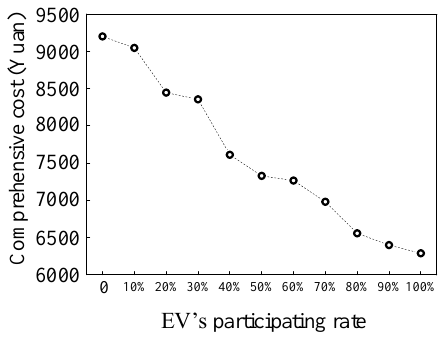
Figure 9. Sensitivity analysis.